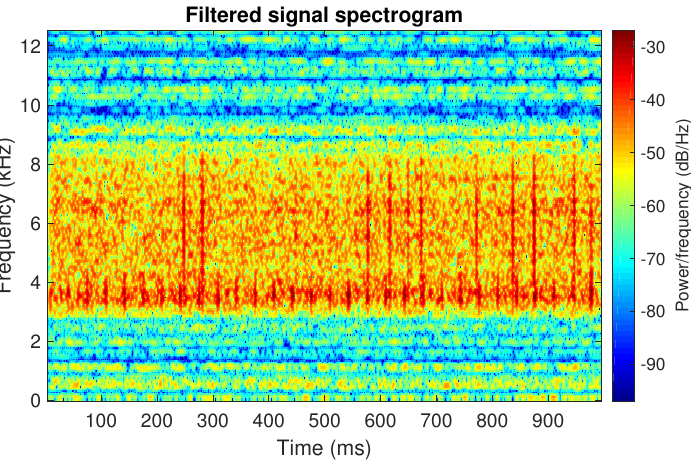
Figure 15. Spectrogram of filtered signal s 2 by Alpha selector.